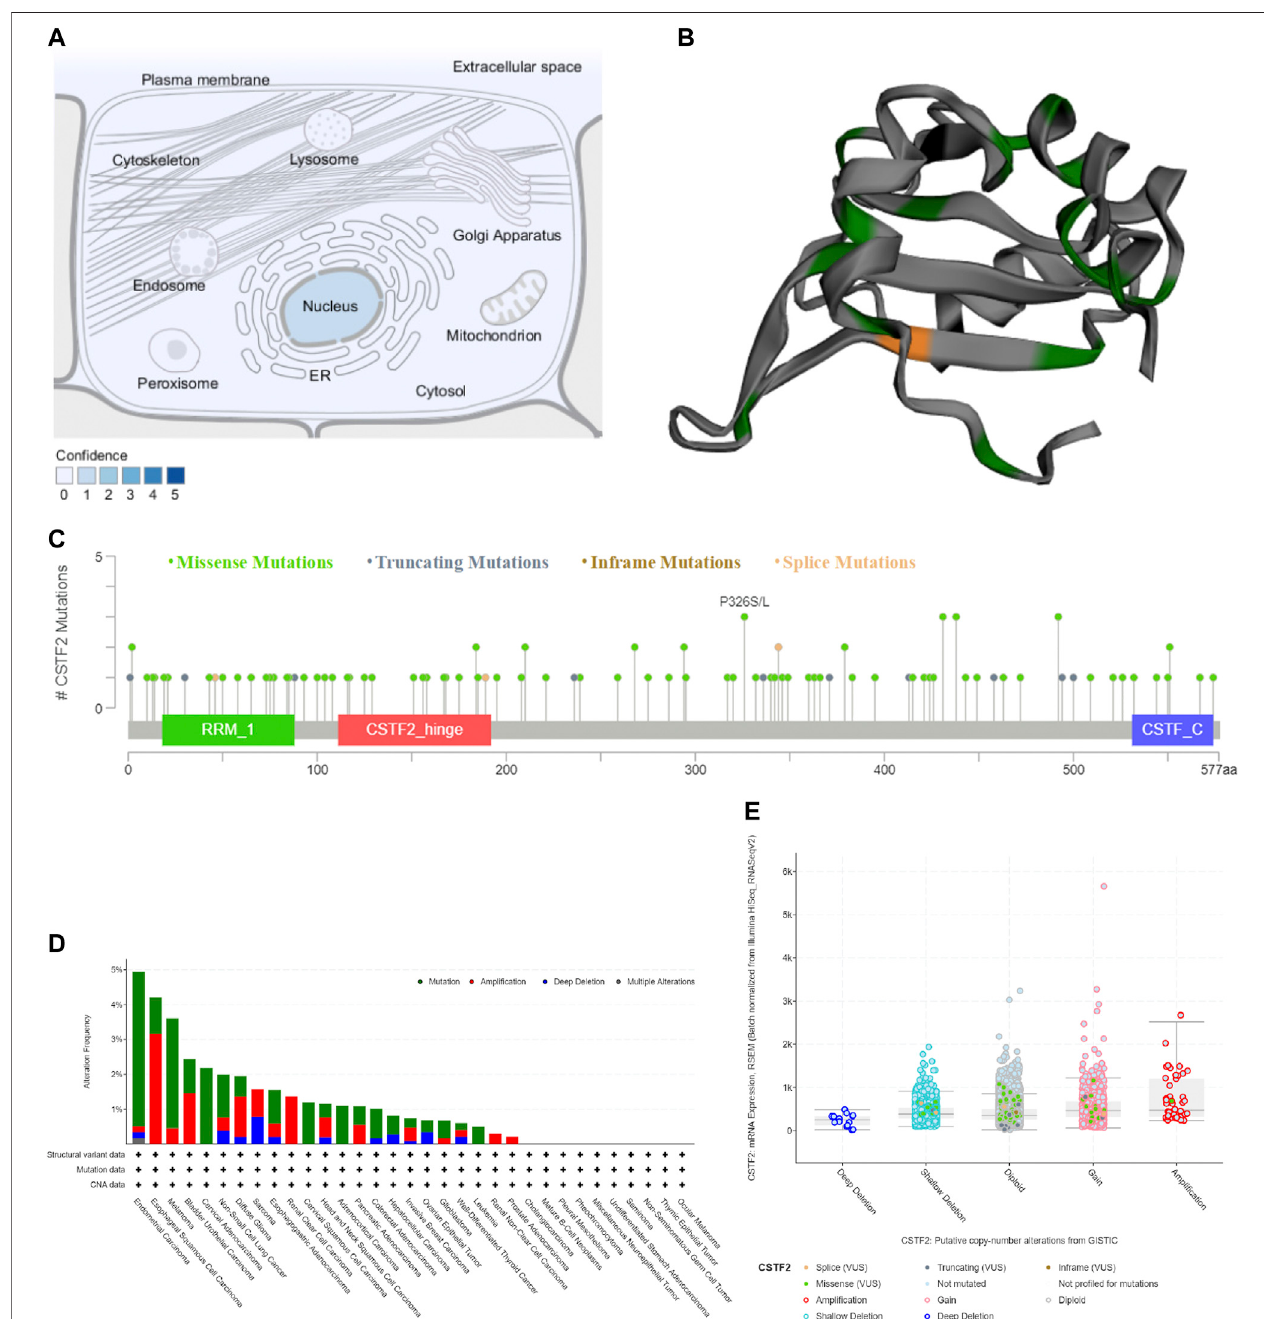
FIGURE 2 | The mutation of CSTF2 . (A) Localization of CSTF2 in subcellular structures. (B) Three-dimensional structure of CSTF2 protein. Green: missense mutations; Grey:truncating mutations; Orange: inframe mutations. (C) Possible sites ofmutation. (D) Mutations of CSTF2 incarcinomatous samples. (E) Putative copy- number alterations from Genomic Identi fi cation of Signi fi cant Targets in Cancer (GISTIC) algorithm.